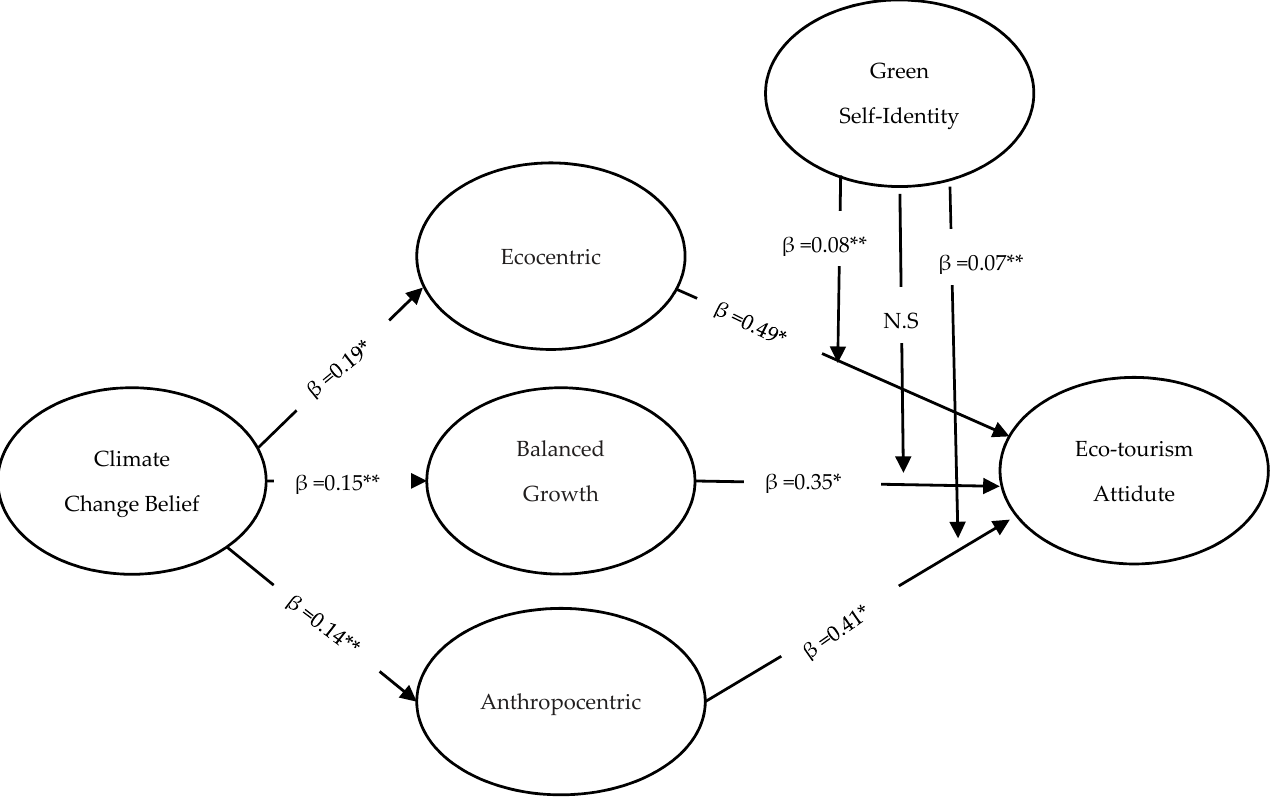
Figure 2. Estimates of structural equation modeling (SEM). * p < 0.001 ** p < 0.05 N.S.: No